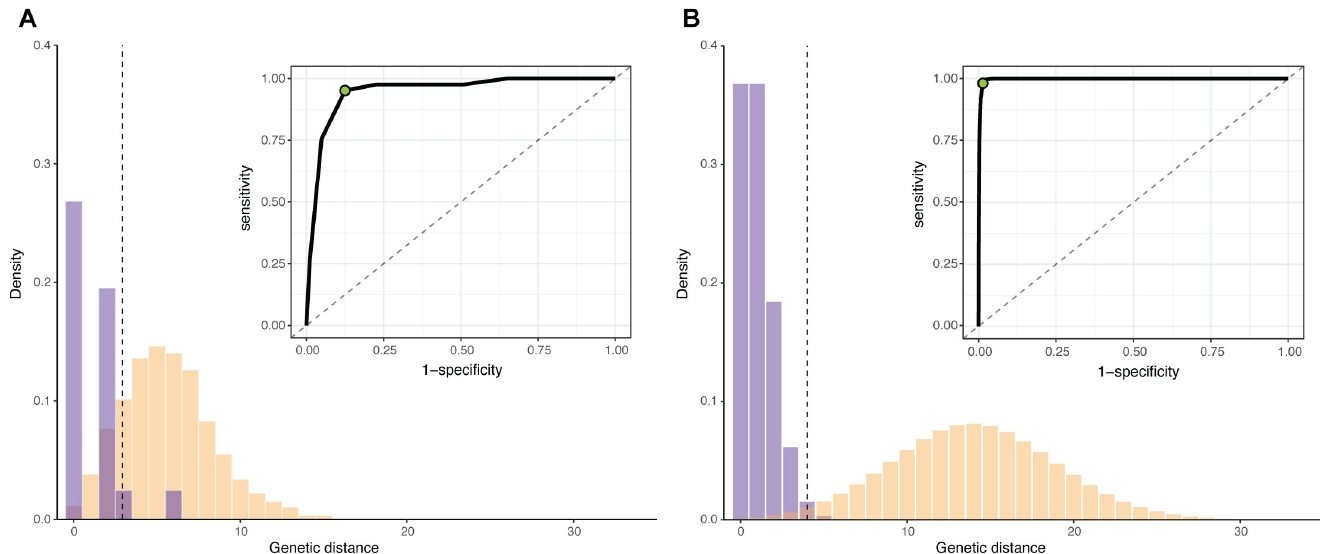
Fig 2. Determining the sensitivity and specificity of a genetic distance threshold. ( A ) Empirical distribution of genetic distances for linked (purple) and unlinked (yellow) infections for 50 infections selected from early in a simulated outbreak ( μ = 1 substitution/genome/generation, R = 2). Inset: receiver operating characteristic (ROC) for all possible genetic distance thresholds. Optimal threshold shown as green dot (ROC) and dashed vertical line (distribution). ( B ) Estimated distribution of genetic distances for linked and unlinked infections generated by the substitution rate method. Parameters and plots are as in (A).